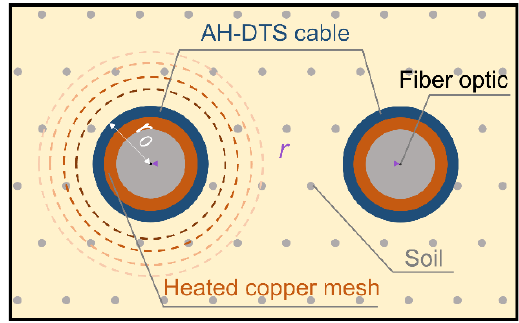
Figure 1. Schematic diagram of the DPHP-DTS method.